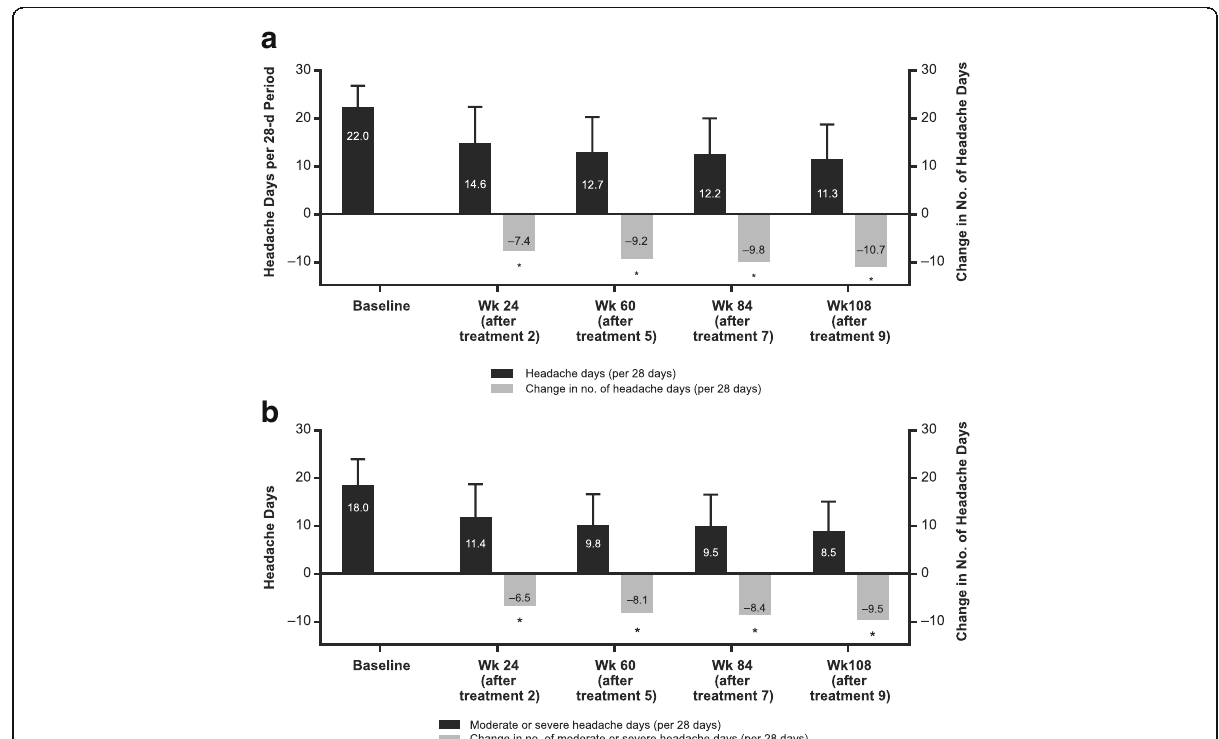
Fig. 4 Long-term effect of onabotulinumtoxinA on number of and change vs baseline. a ) Number of headache days and b ) number of moderate or severe headache days per 28-d period preceding the visit over 108 wk. (depicting the outcomes of treatment after 9 cycles). * P < 0.0001; paired t -test used to compare visit to